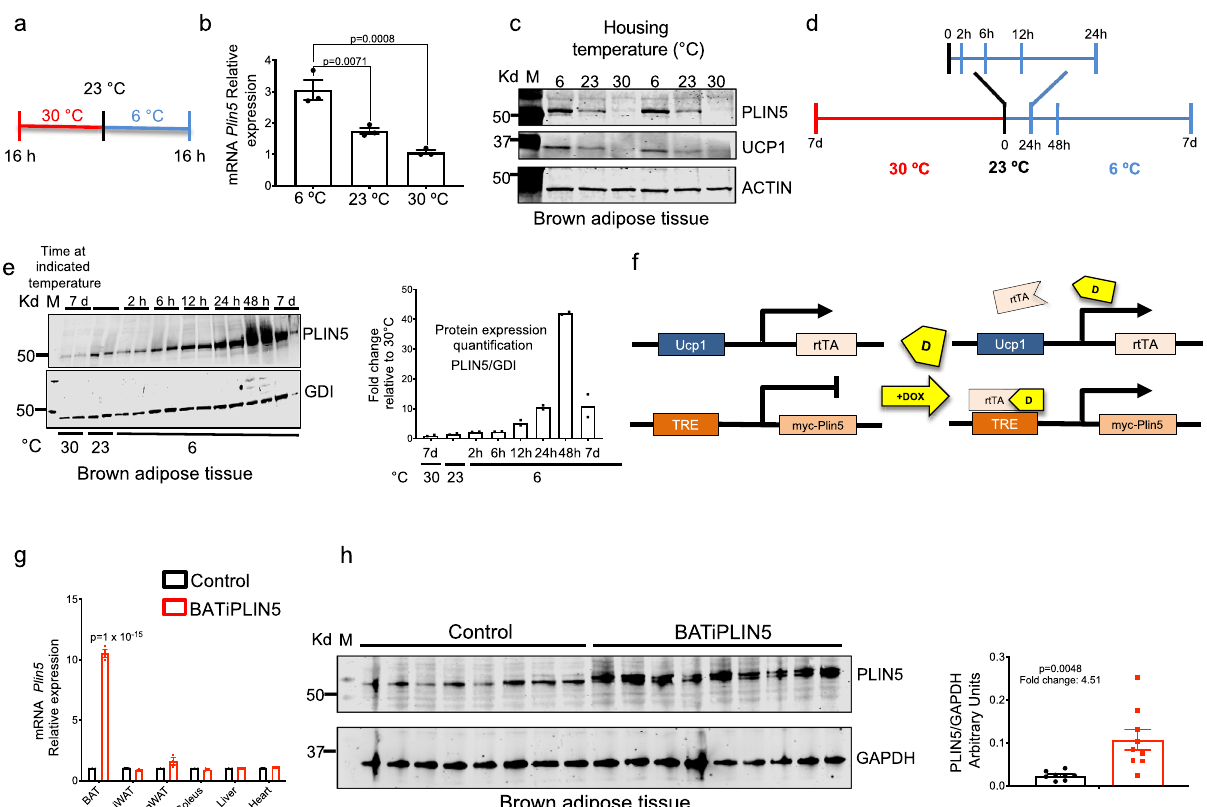
Fig. 1 PLIN5 expression in brown adipose tissue is regulated by temperature and generation and validation of inducible, BAT-speci fi c PLIN5 transgenic mice (BATiPLIN5). a Timeline for controlled temperature experiments depicted in b and c . We collected samples for RNA and western blot (WB) at the indicated time points. b qPCR for Plin5 relative mRNA expression in brown adipose tissue (BAT) from wild-type mice (C56BL/6J) housed at the